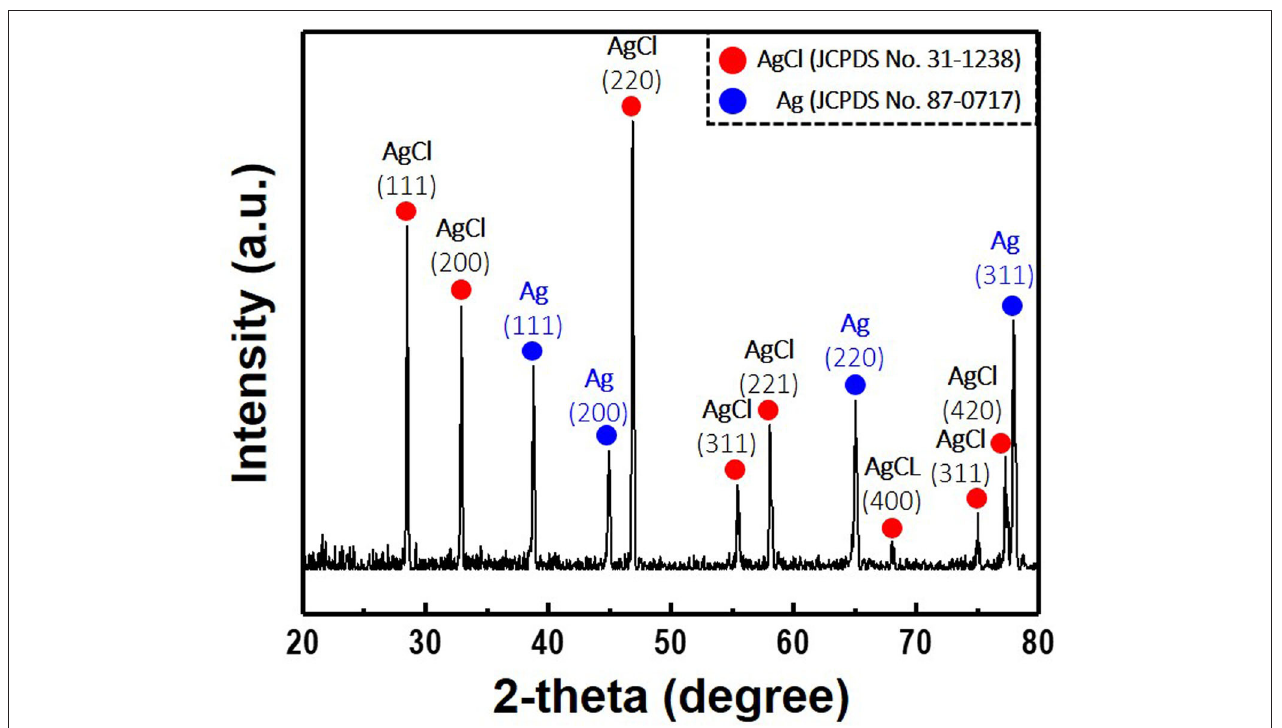
FIGURE 6 | X-ray diffraction patterns of the Ag/AgCl wire synthesized via galvanostatic polarization and immersion (120s) in 1M hydrochloric acid. Current density and treatment time for the galvanostatic polarization are fixed at 30 mA/cm 2 and 2h, respectively.